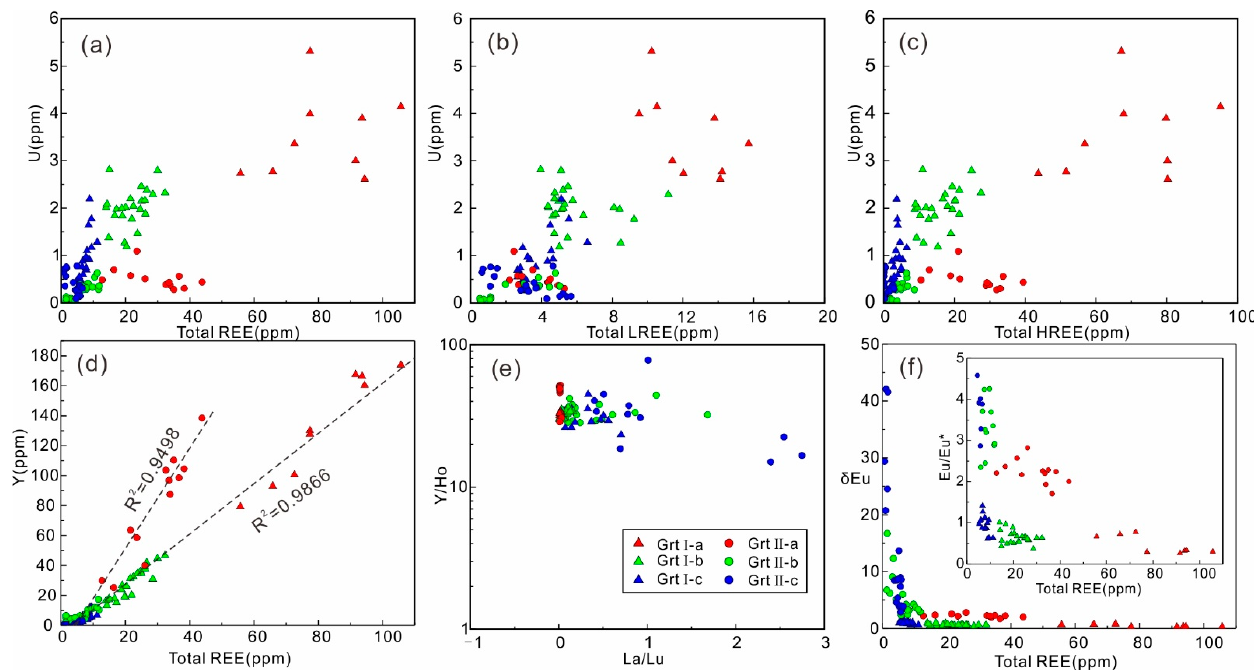
Figure 13. Binary plots of ( a ) ∑ REE vs. U; ( b ) LREE vs. U; ( c ) HREE vs. U; ( d ) HREE vs. Y; ( e ) La/Lu vs. Y/Ho.; ( f ) ∑ REE vs. δ Eu. The chondrite normalization values are from [49].